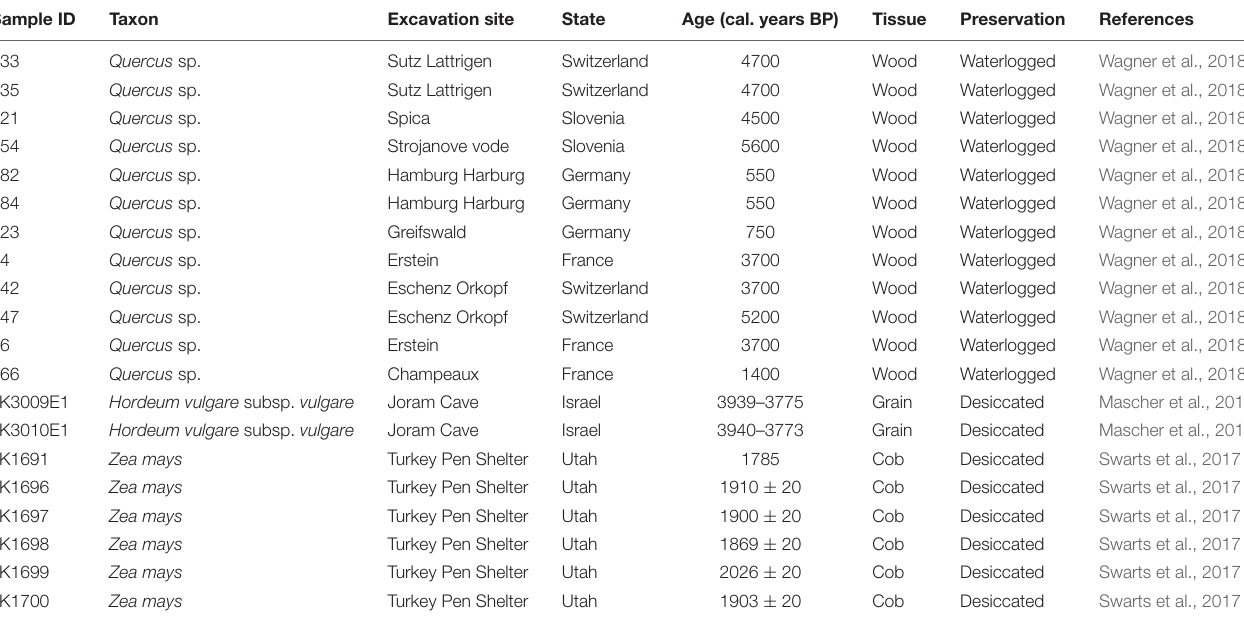
TABLE 1 | Summary of samples analyzed in this